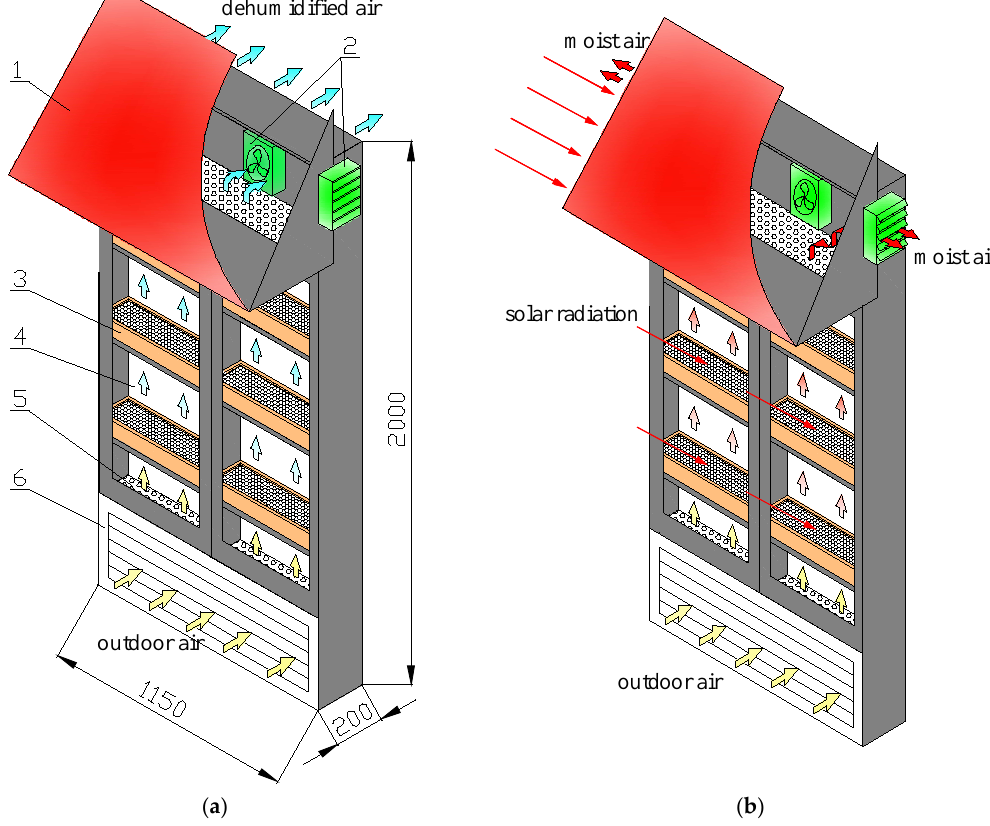
Figure 1. Schematic of the solar-powered dehumidification window (SPDW): ( a ) dehumidification mode; and ( b ) regeneration mode 1-Photovoltaic panel; 2-Fans; 3-Desiccant modules; 4-Flat-plate glass; 5-Orifice plates; 6-Air inlet.